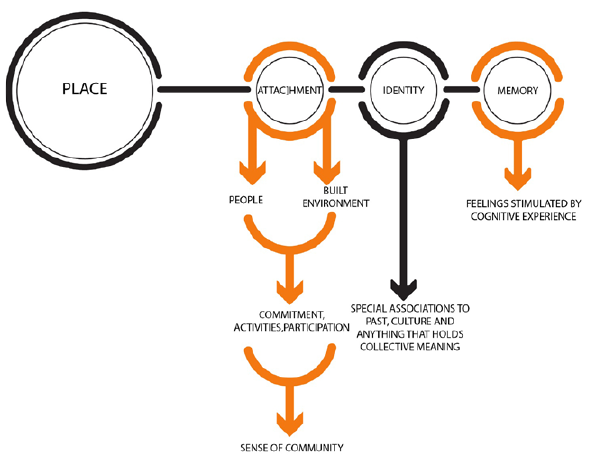
Figure 1. Place determinants/values (developed by Zahid,